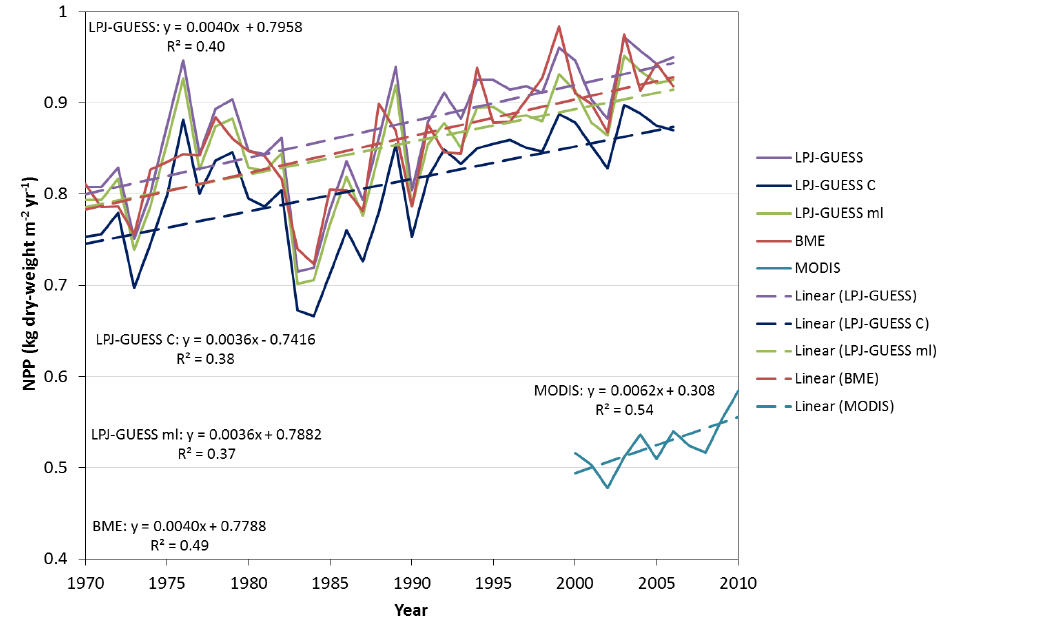
Figure A5. Regional NPP annual means of NPP for BME, LPJ-GUESS, LPJ-GUESS C (carbon only), LPJ-GUESS ml (managed land; 1970–2006), and MODIS (2000–2010) for the greater Sahel